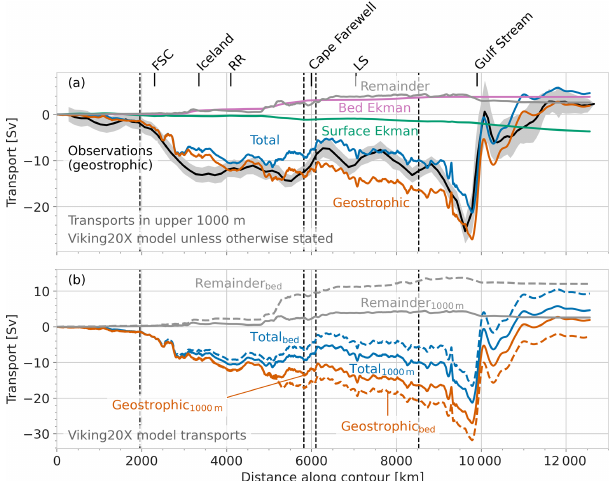
Figure 7. (a) Comparison between observed cumulative geostrophic volume transport into the SPG (annual mean) and transport components above 1000m in VIKING20X. Key locations around the boundary are labelled as in Fig. 3, and vertical dashed lines denote OSNAP crossings. he remainder is calculated as the total transport minus the geostrophic, surface Ekman, and bed Ekman transport components. (b) Comparison between transports into the SPG in VIKING20X using a strict 1000m cutoff and integrating to the bed along the 1000m contour (but still integrated to 1000m across 47 ◦ N). The difference is due to the stepped model topography and associated inability to follow the 1000m bathymetry